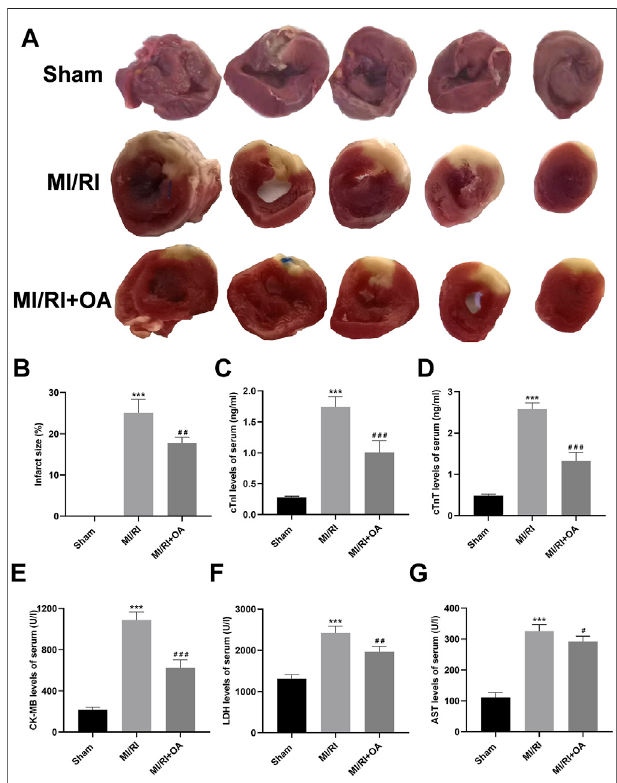
FIGURE5| OAtreatmentameliorates MI/RI invivo (A,B) Representative TTC staining images and quantitative analysis for the heart tissues in each group (C – G) ELISA results showing that serum levels of cTnI, cTnT, CK-MB, LDH, AST in each group. Data are presented as the mean ± SD. ppp p < 0.001, compared with the Sham group; # p < 0.05, ## p < 0.01, and ### p < 0.001, compared with the MI/RI group. MI/RI: myocardial ischemia/ reperfusion injury; OA: Oroxin A; TTC: 2,3,5-Triphenyltetrazolium chloride; ELISA: enzyme-linked immunosorbent